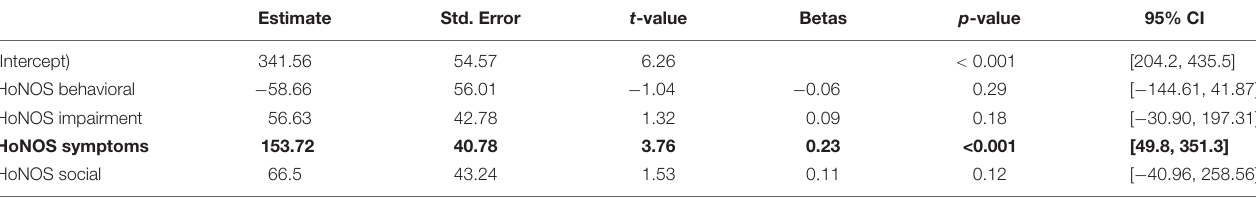
TABLE 2 | Association of Health of the Nation Outcome Scale (HONOS) subscales with the length of stay. Estimate Std. Error t -value Betas p -value 95% CI